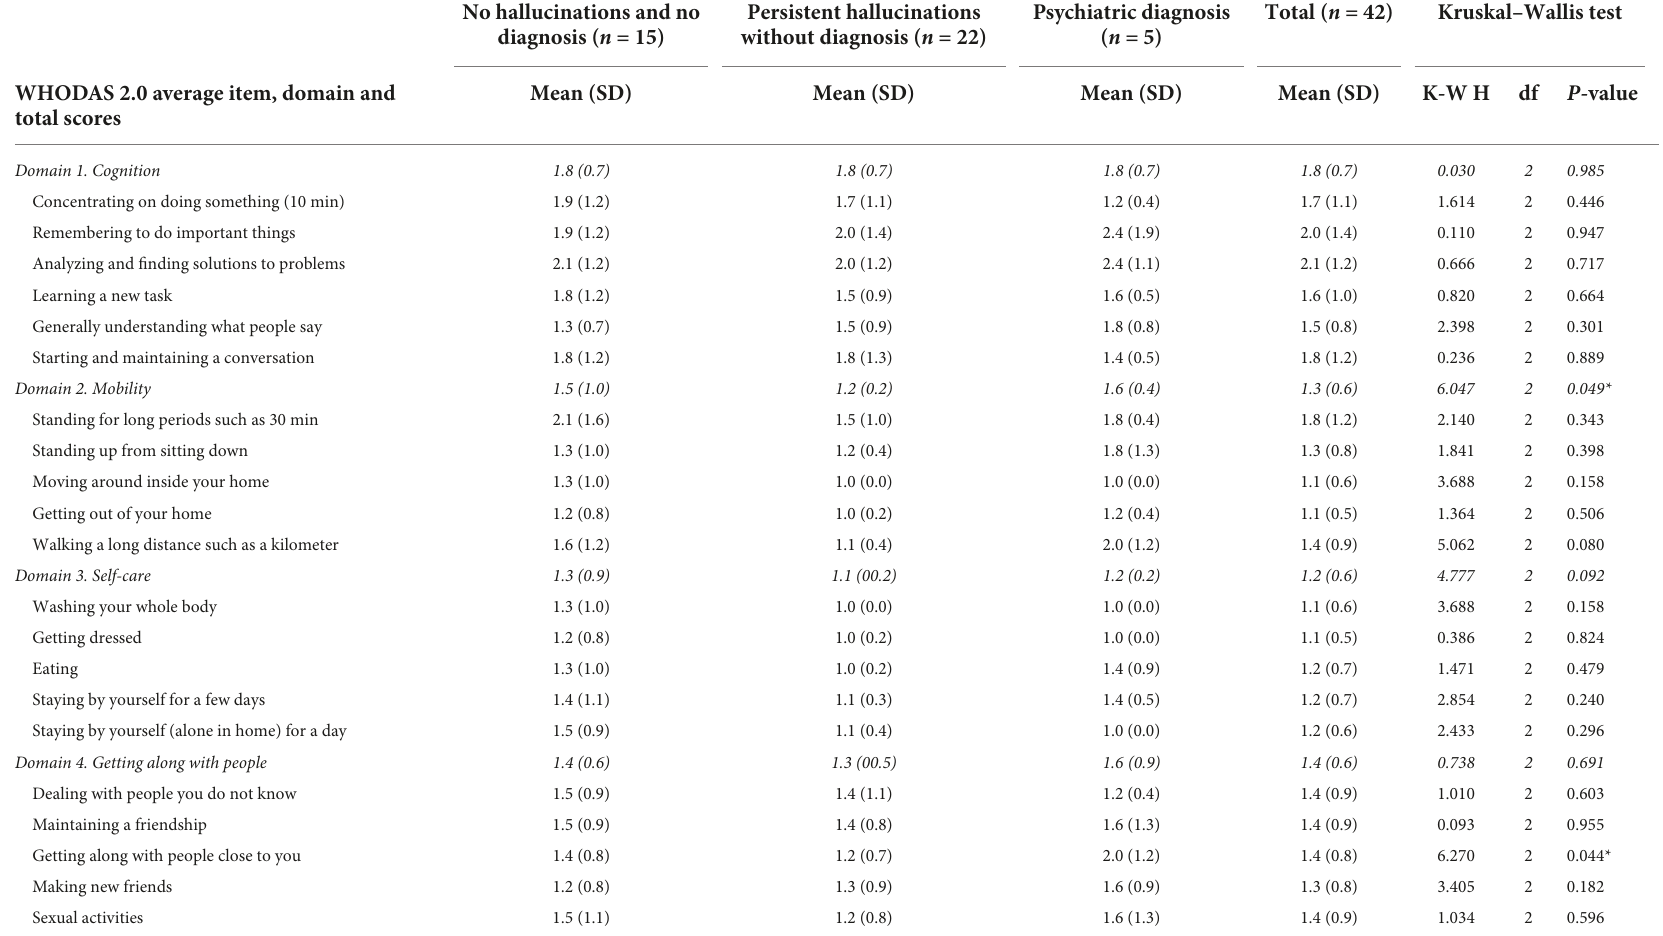
No hallucinations and no Persistent hallucinations Psychiatric diagnosis Total ( n = 42) Kruskal–Wallis test diagnosis ( n = 15) without diagnosis ( n = 22) ( n = 5) Mean (SD) Mean (SD) Mean (SD) Mean (SD) K-W H df P -value